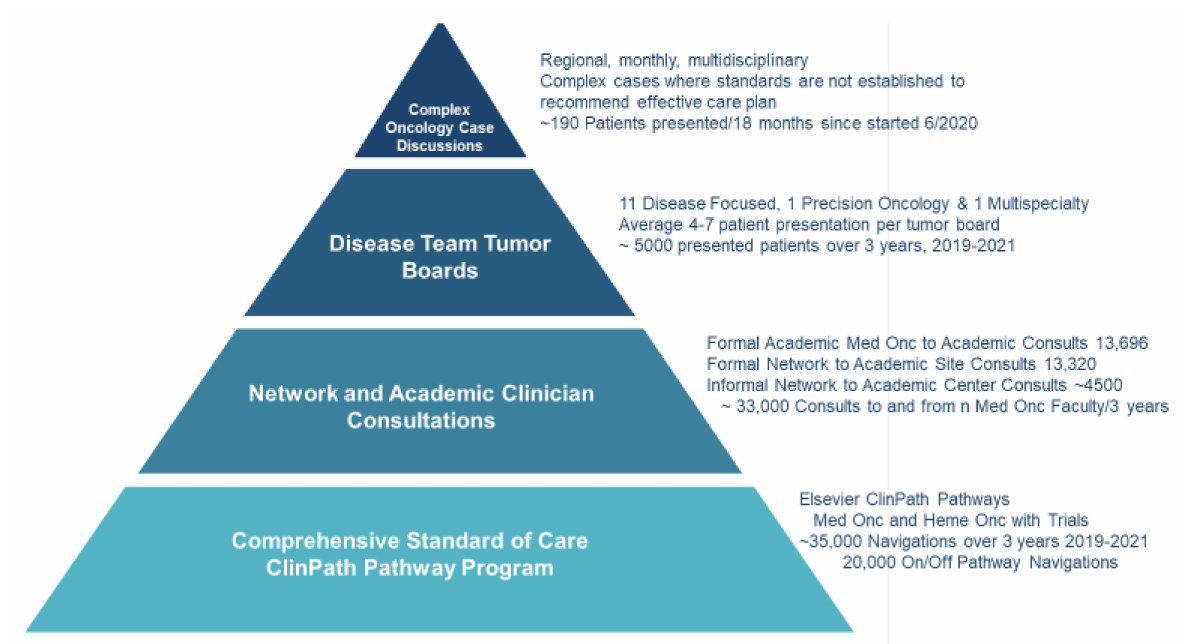
Figure 1. Four Components of the Pyramid of Decision Support for COH